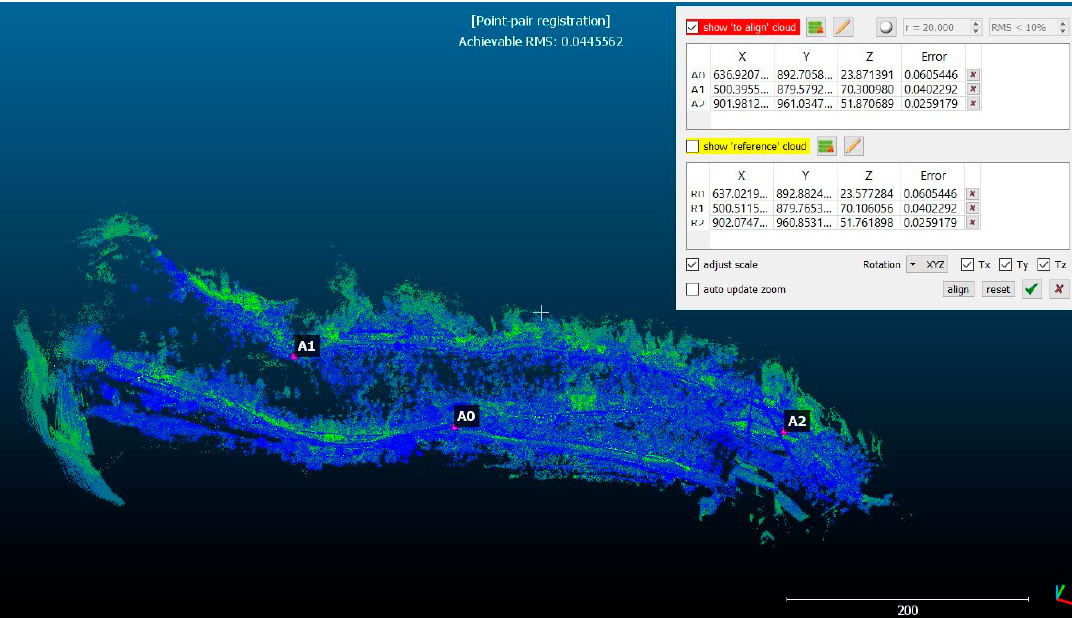
Figure 15. Point-pair registration between MMS (Mobile Mapping System) point cloud and natural photogrammetric check points.